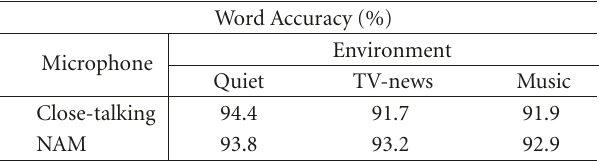
Figure 20: F0 contour of normal speech—NAM microphone. Table 3: Recognition rates for audible speech.